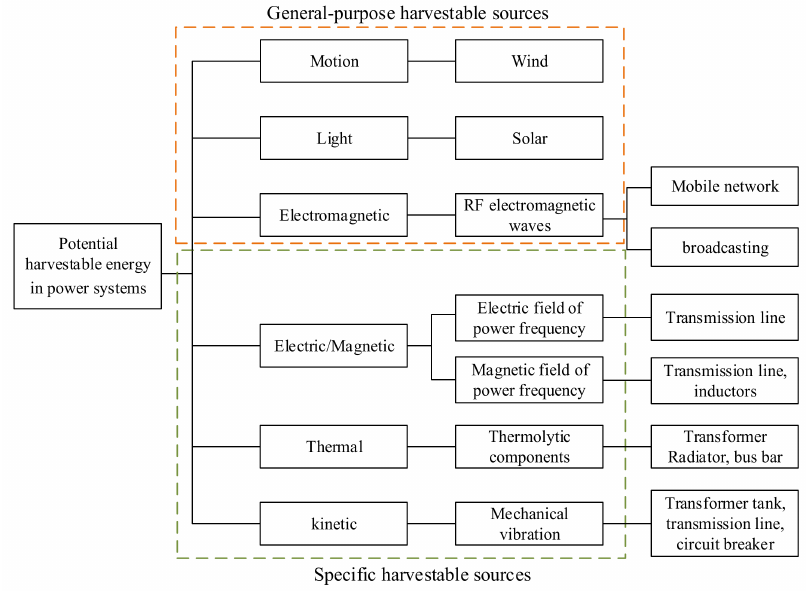
Figure 1. Profiles of harvestable energy sources in the context of power